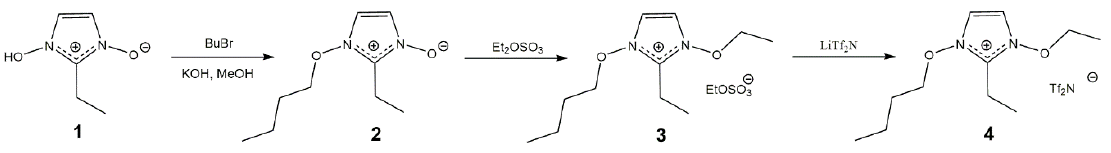
Figure 1. Synthesis scheme of [BuEtEtIMO] [Tf 2 N].